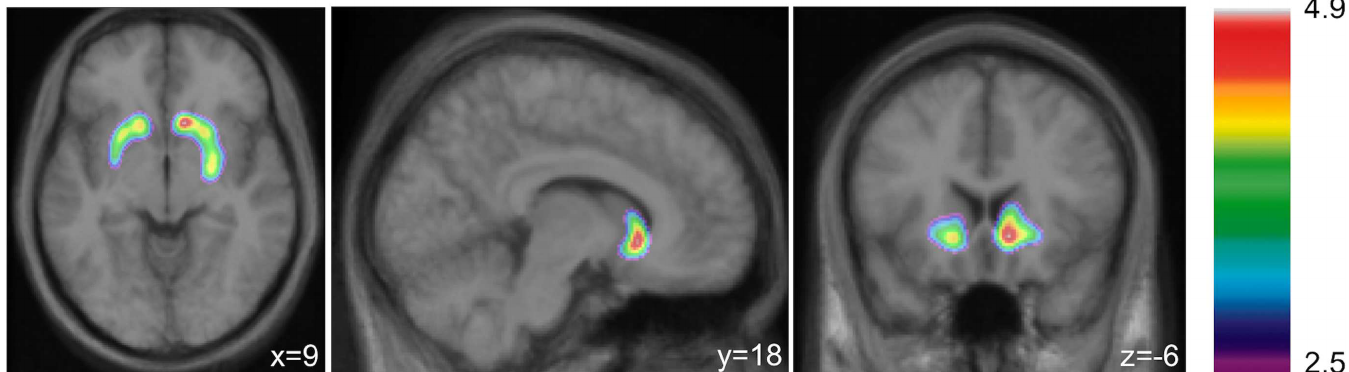
Fig 3. Voxel-wise t-map of binding potential. Voxel-wiset-map of [ 11 C]raclopridebindingpotential (BP ND ) illustratingreducedBP ND (i.e., greater dopamine release)followingamphetamine vs . baseline( t > 4.1, p < .05corrected). No significantvoxels were noted outsidethe striatum.